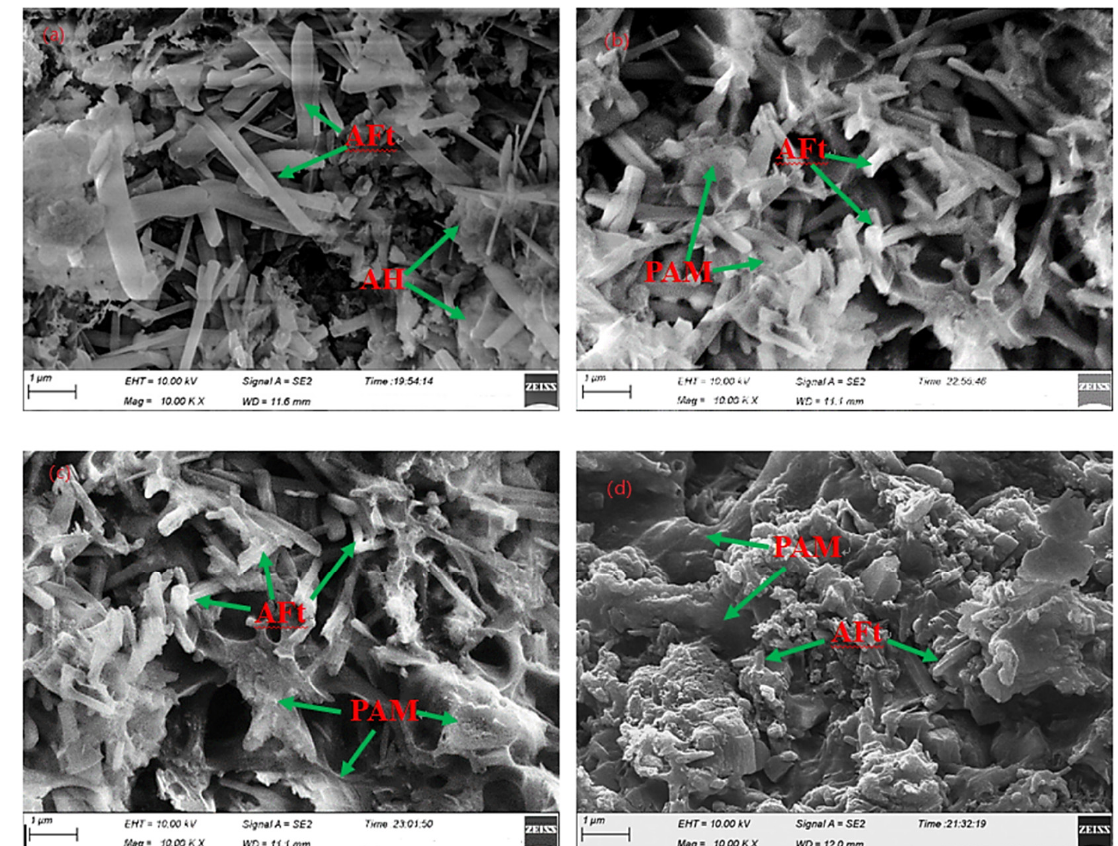
Figure 16. SEM photos of 3 d specimens: ( a ) 0% PAM; ( b ) 15% PAM; ( c ) 25% PAM; ( d ) 35%PAM.